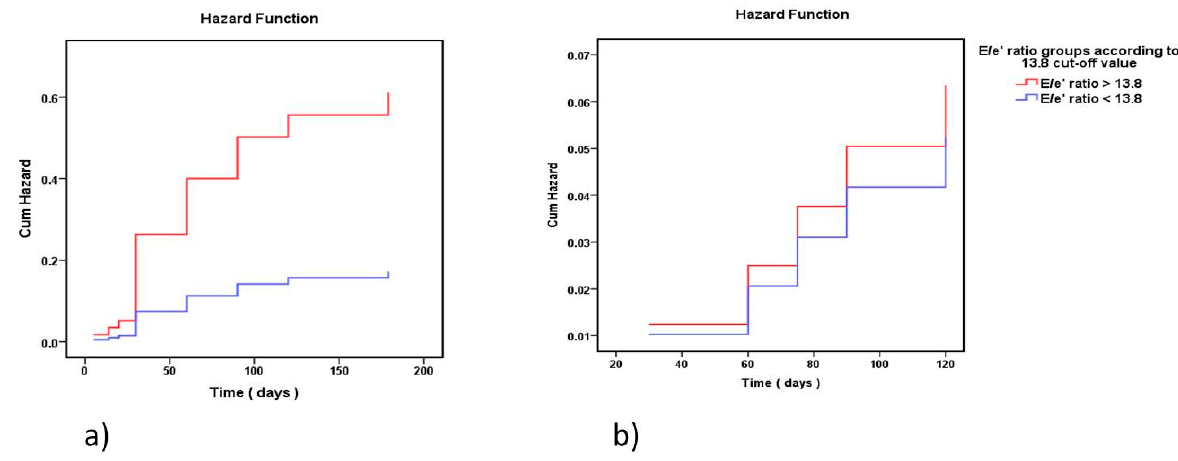
Figure 4. The risk curves for HFR ( a ) and mortality ( b ) in the 6-month follow-up period (Cum Hazard) according to Cox regression in the two groups: E/e’ ratio < 13.80 (blue), and E/e’ ratio > 13.80 (red) (time in days to readmission). The two curves are significantly apart for ( a ) HFR ( p = 0.006) but not for ( b ) survival ( p = 0.834).